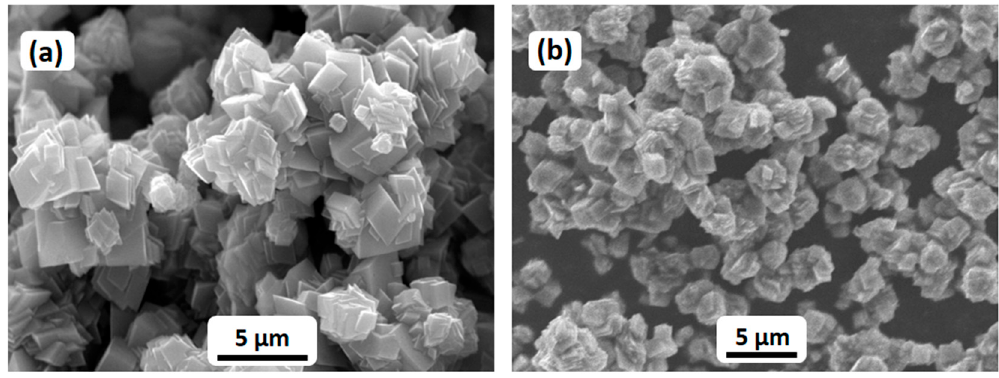
Figure 4. SEM micrographs of ( a ) ZnO x (1%)–MnCO 3 ; and ( b ) ZnO x (1%)–MnCO 3 /(1%)HRG nanocomposite.